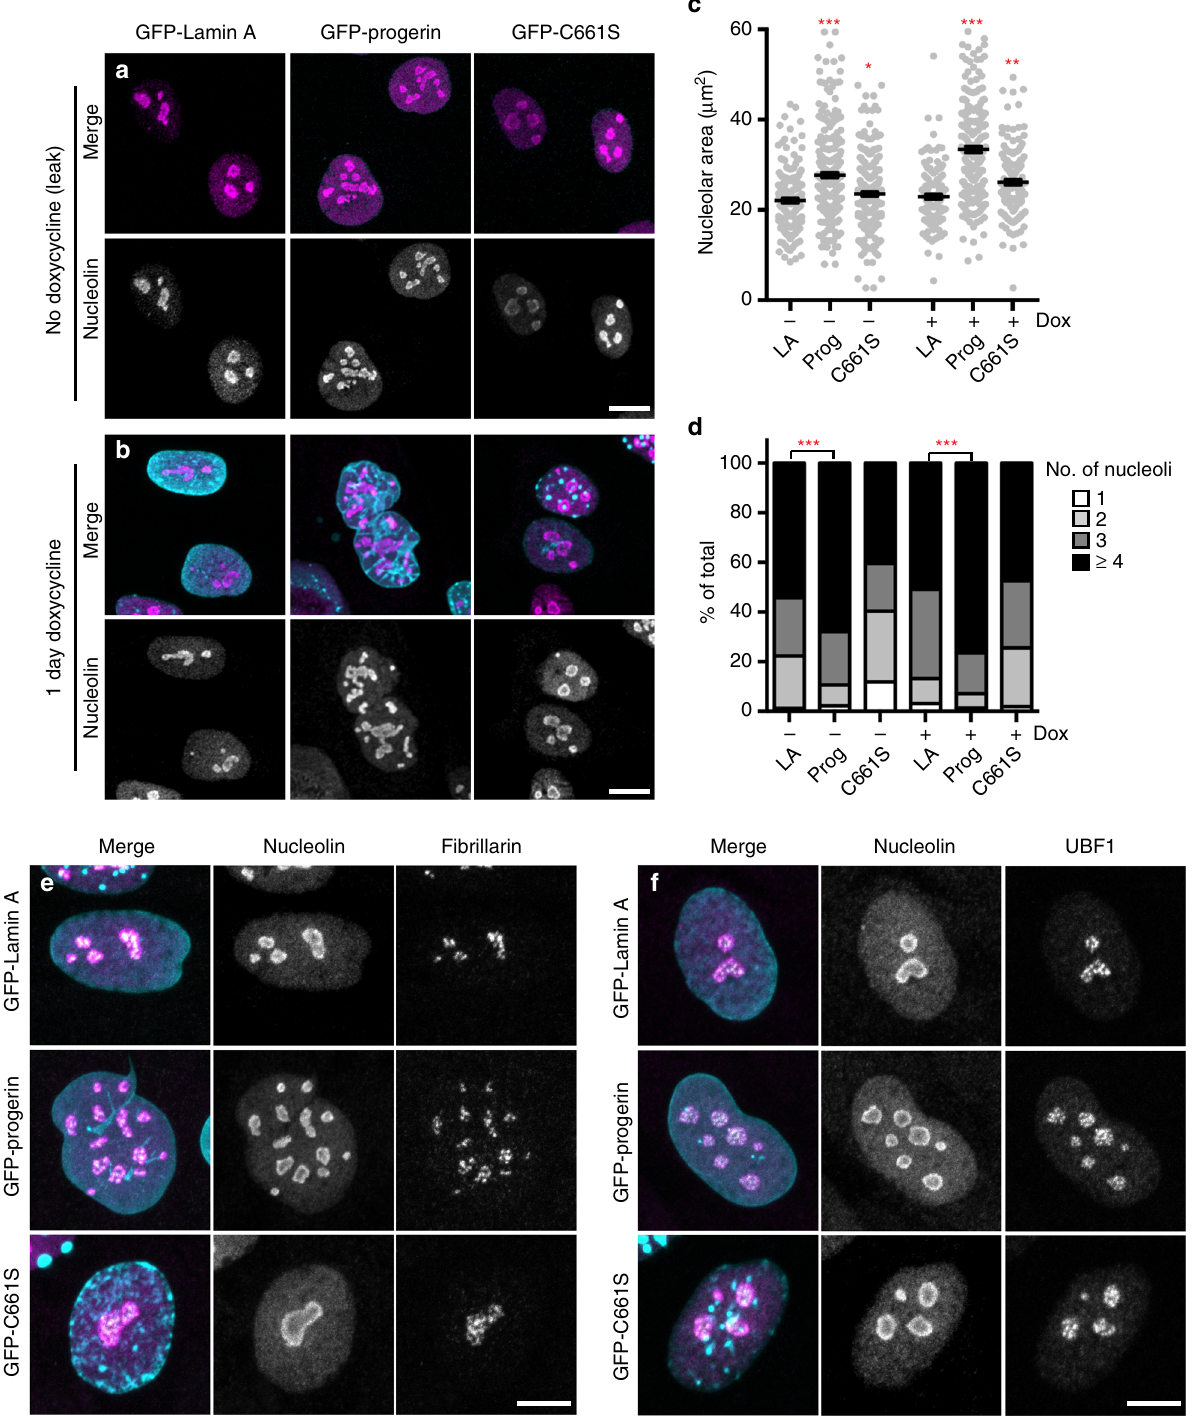
Fig. 5 Progerin expression drives nucleolar expansion. a , b Human fi broblasts expressing GFP-tagged lamin A, progerin, or progerin C661S ( cyan ) under a doxycycline-inducible promoter stained for nucleolin ( magenta ) either in absence of doxycycline a or after 1-day treatment with doxycycline b . Scale bar = 10 μ m. c Total nucleolar area per cell, determined by boundaries of nucleolin immuno fl uorescence. Signi fi cance determined by t -test. Black bars indicate mean ± SEM. d Number of nucleoli per cell. c , d N > 70 cells per condition from three independent experiments with two technical replicates. Signi fi cance determined by χ 2 -test. e , f Staining for nucleolin ( magenta ) and fi brillarin ( gray ) e or UBF1 ( gray ) f in cells expressing the indicated GFP-tagged lamin proteins ( cyan ) after 1 day of doxycycline induction. Scale bar = 10 μ